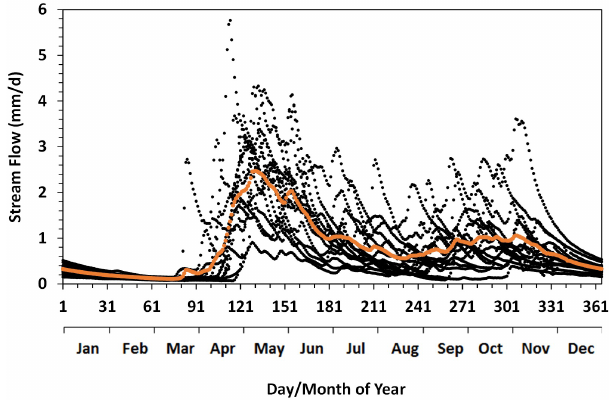
Figure 5. Daily streamflow measured at the gauge station 04HA001 (see Fig. 1) of the Albany River over the study period (2002–2016). Orange dots represent the 15-year mean